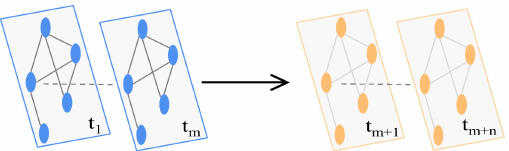
Figure 2. According to historical traffic flow time series graphs, future traffic flow time series graphs can be predicted (here t is time, m is the number of historical time steps, and n is the number of prediction time steps).